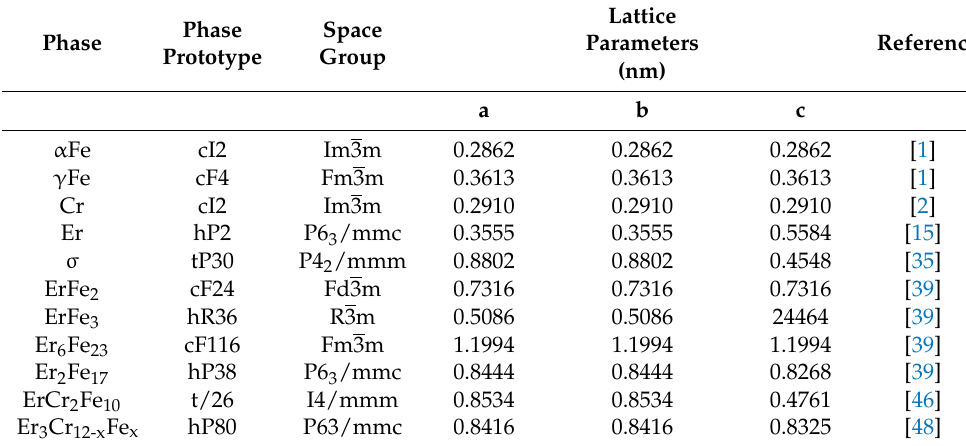
Table 1. Experimental and literature data on crystal structures and lattice parameters of the solid phases in the Fe–Cr–Er system.